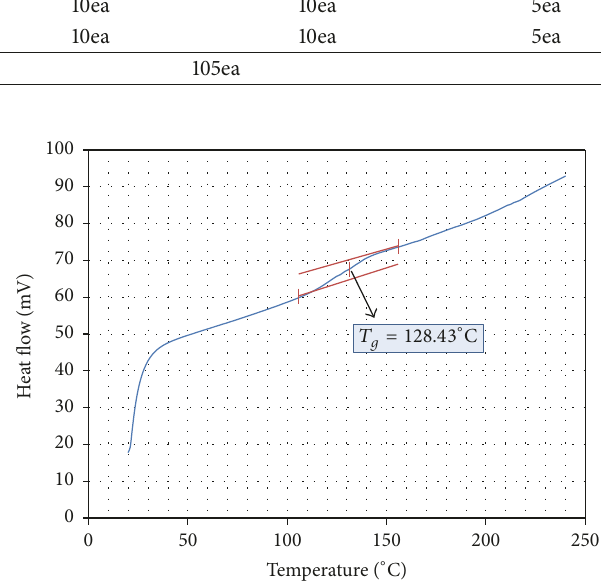
Figure 1: Differential Scanning Calorimetry (DSC) analysis